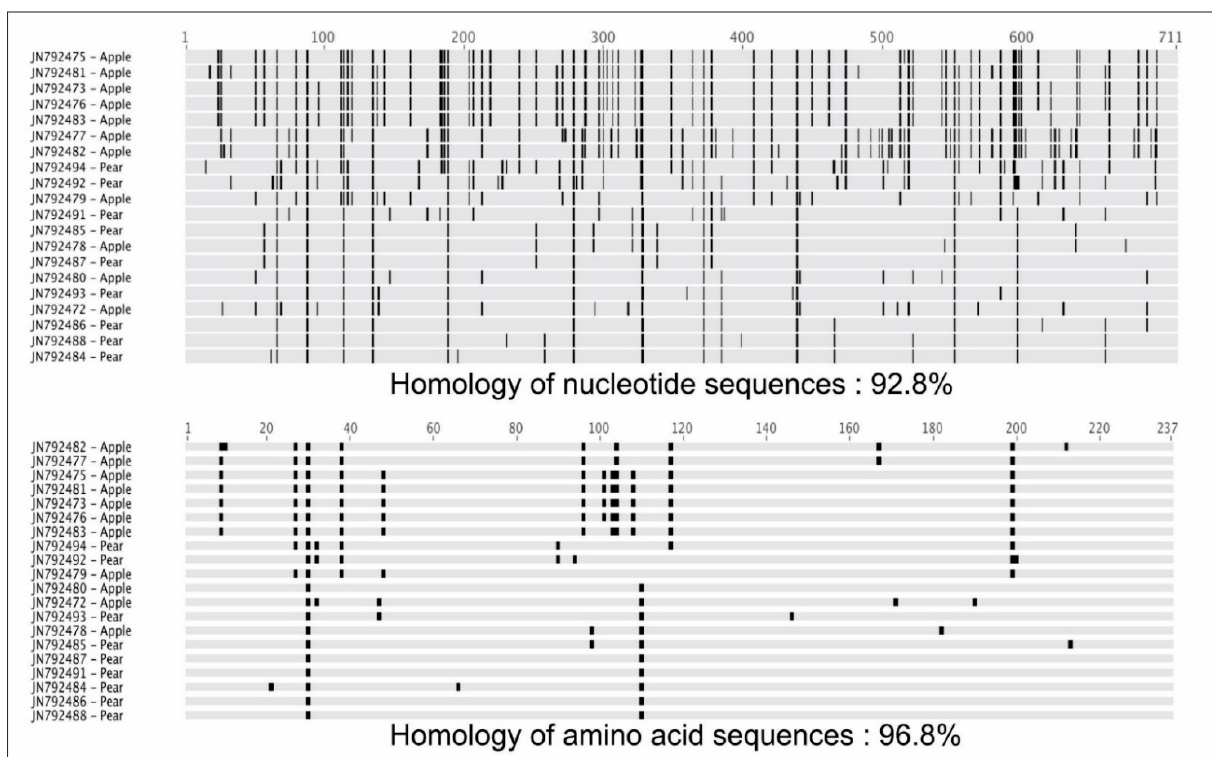
Figure 6. Multi-aligned sequence comparisons between nucleotides and amino acids. Identities of nucleotide and amino acid sequences were different from each other. Black highlighted positions represent differences between residues and the consensus sequence. Nucleotide sequences showed various residue substitutions coding for the same amino acids.